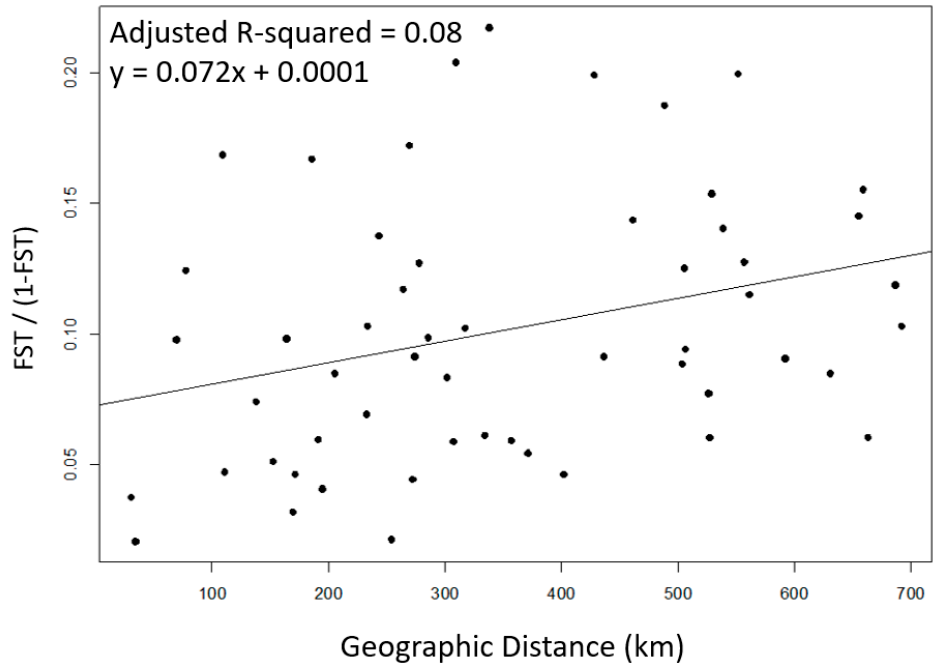
Figure 3. Relationship between genetic distance and geographic distance among wild Oreochromis niloticus collected from 11 sites in Ghana from December 2014 and July 2017.